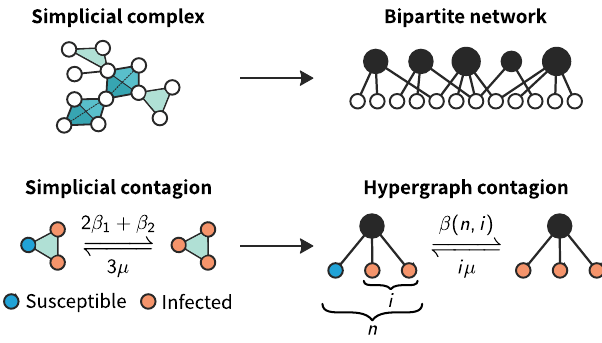
Fig. 1 Mapping of the simplicial contagion model to a hypergraph contagion. We use a bipartite representation, where nodes (white circles) belong to groups (black circles). A facet of dimension n − 1 is mapped onto a group of size n . In the simplicial contagion model, contributions from higher-order interactions are taken into account by additional transmission rates (e.g., β 2 for the 2-simplex) when all but one node of the simplex are infected 31 . With our hypergraph representation, infections within a group are simply modeled by a general infection function β ( n , i ) that depends on both the size n of the group and the number i of infected nodes in the group (with i ≤ n